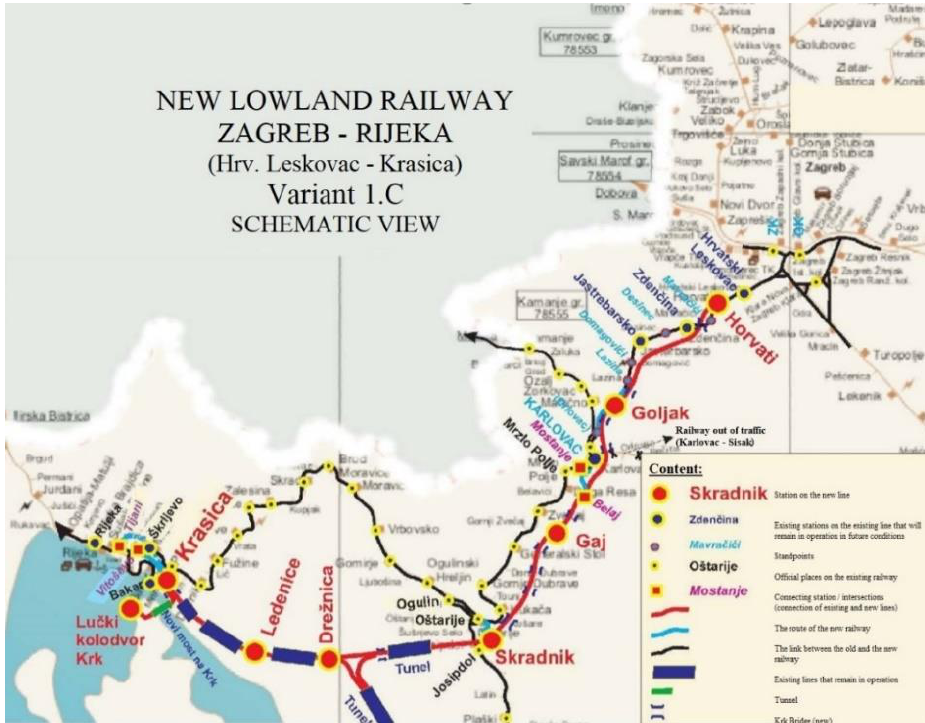
Figure 3. An overview of variant 1C [50].